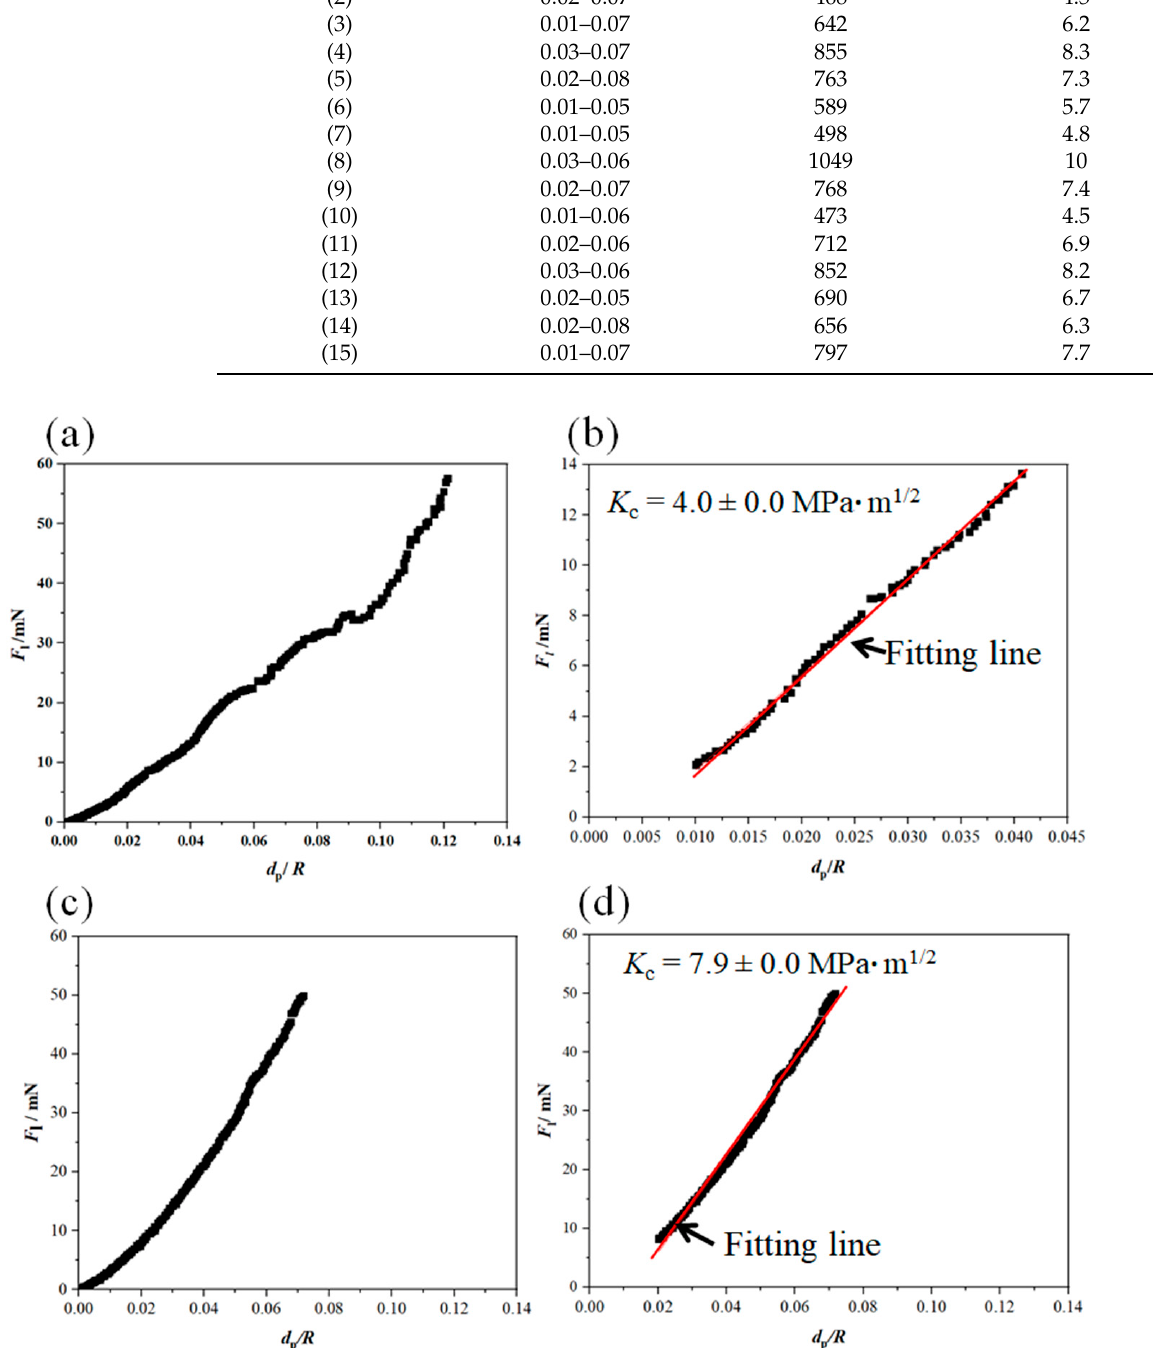
Figure 9. F l ( d p /R ) curve and the related fitting-range curve for the nano-scratch on the Al 2 O 3 coating ( a , b ) and on the Al 2 O 3 -ZrO 2 coating ( c , d ). These curves were extracted from the nano-scratch results presented in Figure 7.